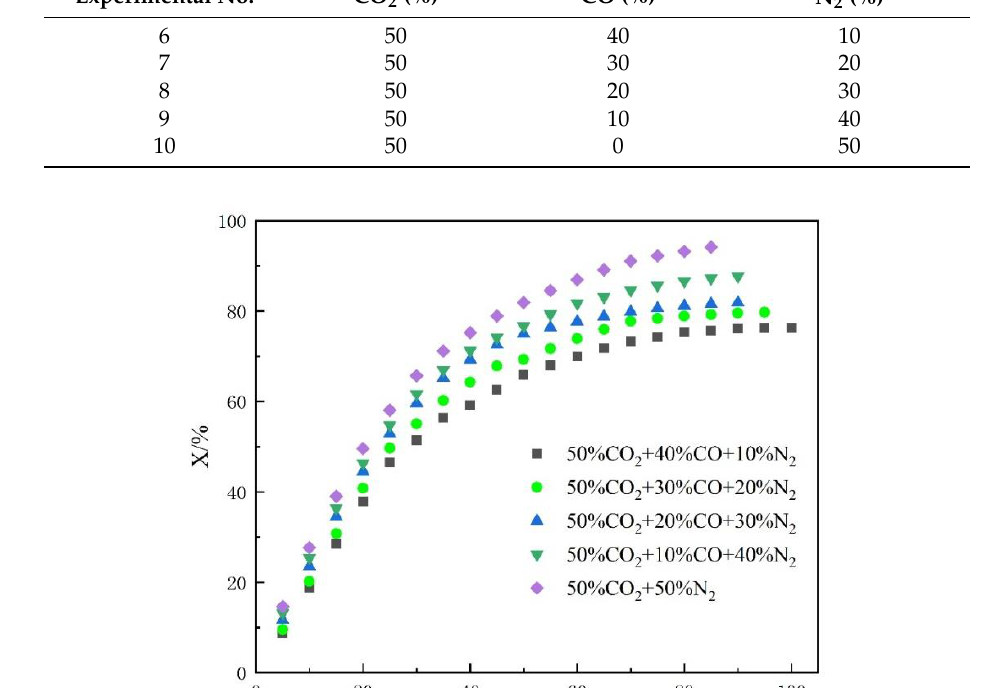
Table 6. Experimental arrangement of bituminous char gasification in the mixture of CO 2 , CO and N 2 . Experimental No.